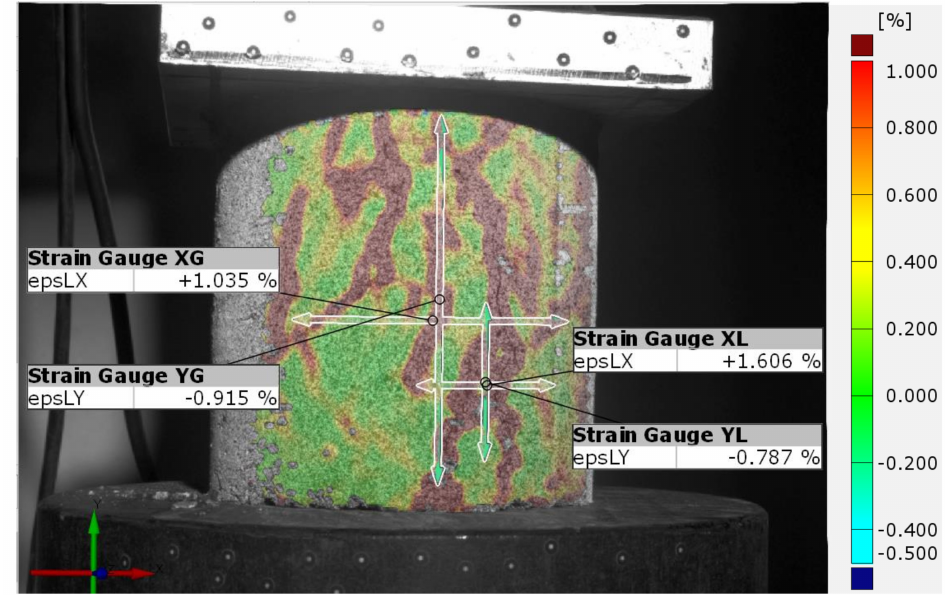
Figure 12. Example of using strain gauges to measure deformation at the specimen surface and in the emerging